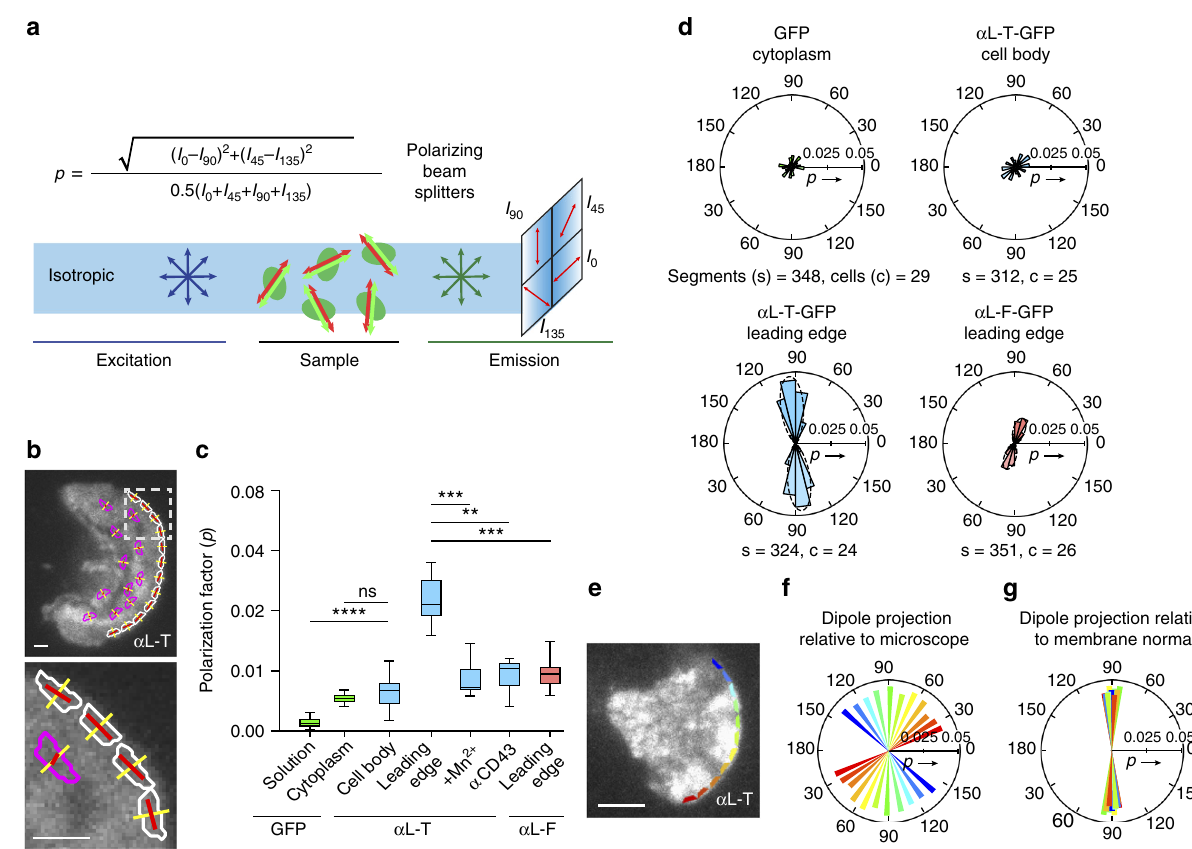
Fig. 5 Integrin alignment and orientation in migrating T cells measured by instantaneous FluoPolScope. a Schematic of Instantaneous FluoPolScope 40 and equation for polarization factor p . b Representative total fl uorescence intensity image of α L-T Jurkat T cell migrating on ICAM-1 (10 µ g/ml) with overlay of ROIs (white = leading edge, magenta = cell body), normal to leading edge tangent (yellow), and average GFP emission dipole orientation with length proportional to polarization factor (red). Scale bars = 1 µ m. Panel below is enlarged from dashed area. c Polarization factors of GFP and GFP-LFA-1 fusions in T cells migrating in random directions. Box plots show the full range (whiskers) of observations with median as line and 25 – 75 percentile range boxed. Kruskal – Wallis test with multiple comparison correction of leading edges gave the indicated P values to α L-T using N number of cells shown in d . ** p < 0.01, *** p < 0.001, **** p < 0.0001. d Radial histograms of GFP transition dipole projection in image plane relative to the membrane normal ( θ d ). Each radial histogram wedge shows mean intensity-weighted polarization factor ( p ) in 15° bins (solid outlines) and is re fl ected to represent the dyad symmetry axis of the dipole. Dashed propeller-shaped outlines in the lower two panels show the fi t of the data to a circular Gaussian. e – g , e A representative α L-T Jurkat cell migrating on ICAM-1 was segmented as shown in b . Segments are color coded in blue-red rainbow around the leading edge and are shown in same color in f , g . Each segment is represented as a re fl ected wedge at the angle of its experimentally measured emission dipole projection with respect to the x axis f or with respect to the membrane normal ( θ d ) (Supplementary Fig. 4b, c). The value of anisotropy ( r ) was fi t to the inset equation in Supplementary Fig. 4a with the angles γ and fi ned relative to the long axis of actin fi laments. Fits of the θ d de cos 2 dependence of anisotropy gave θ d = 86° ( R 2 = 0.96) for SiR- actin and − 2.9° ( R 2 = 0.91) for Alexa488-phalloidin (Supplemen-